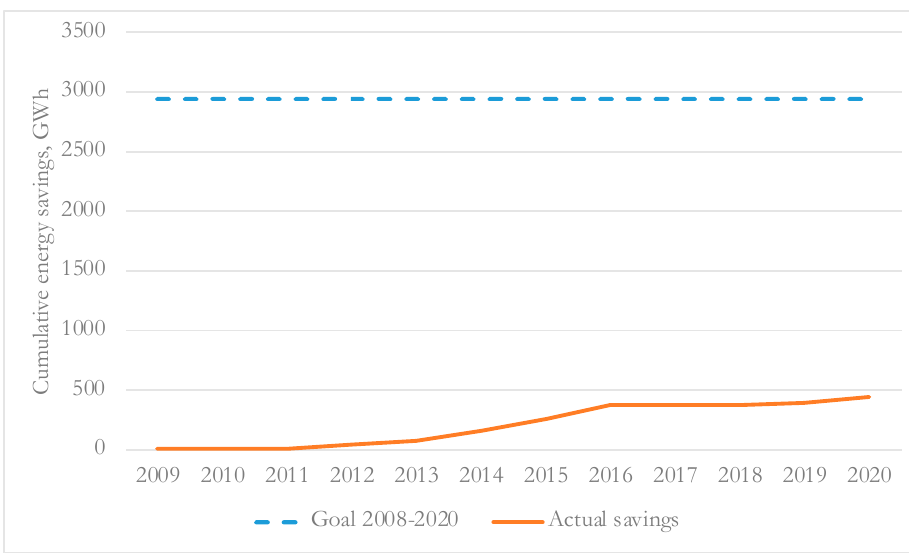
Figure 1. Actual and planned cumulative energy savings for multi-family buildings in Latvia.